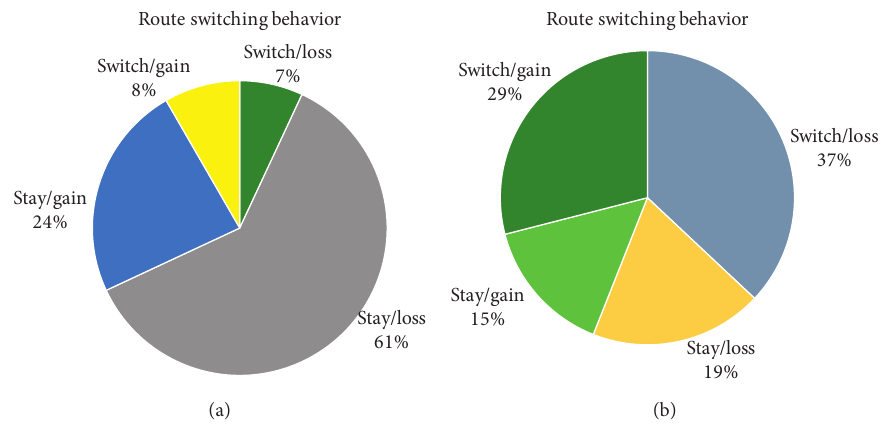
Figure 3: Route choice behavior under Scenario 2 and Scenario 4. (a) Scenario 2 (b); Scenario